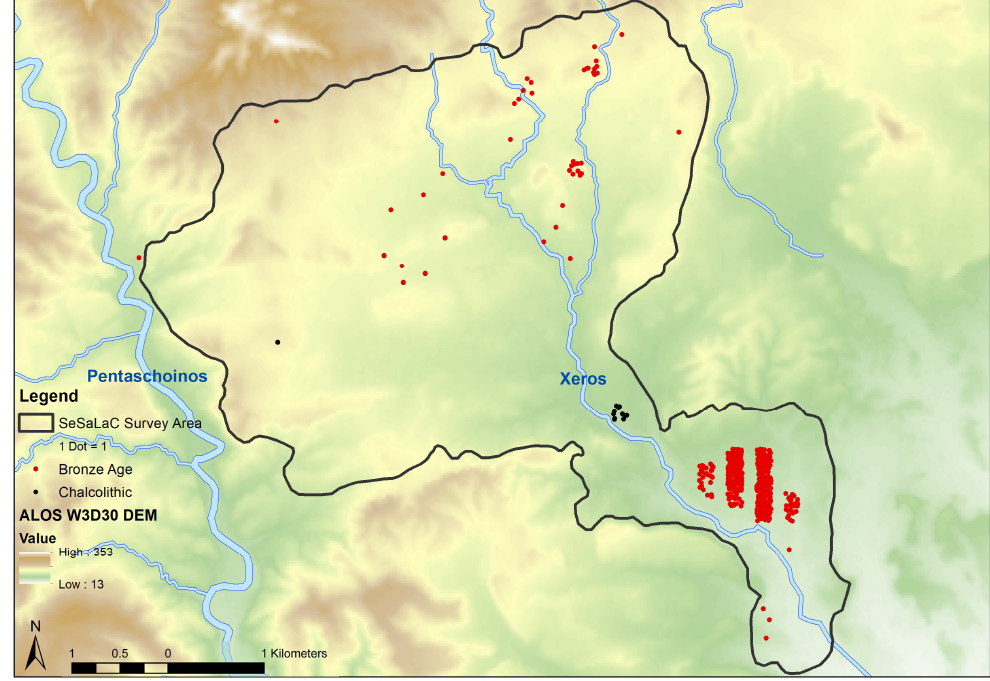
Figure 5. Chalcolithic and Bronze Age pottery distribution. ALOS DEM are in metres. Digital data courtesy of the Geological Survey Department, Republic of Cyprus (Map by Charalambos Paraskeva).